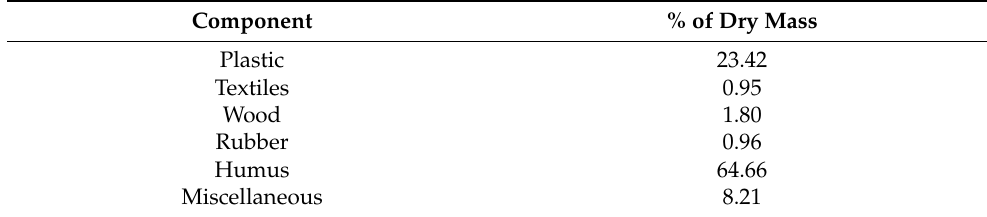
Table 1. Composition of the waste from Beiyangqiao landfill.